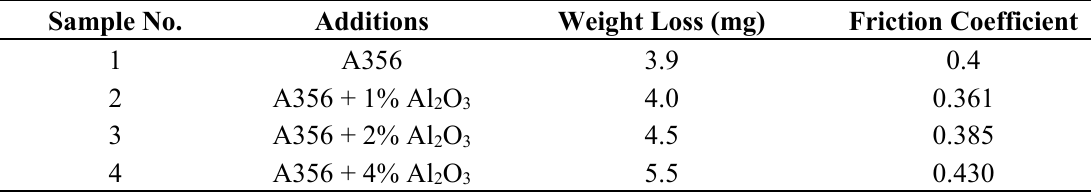
Table 5. The average wear results of A356 samples reinforced with 0, 1, 2 and 4 weight% Al 2 O 3